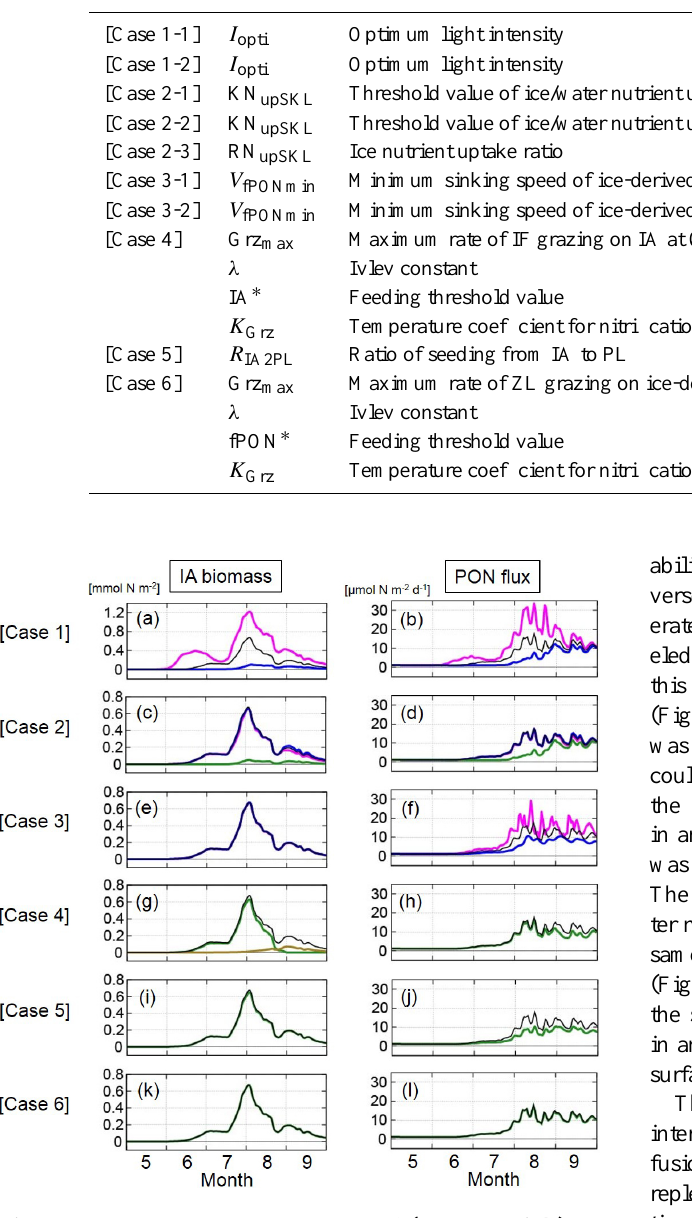
Table 3. Parameters in the sensitivity experiments. Formulations are shown in Sects. 2.2 and 5. Parameter